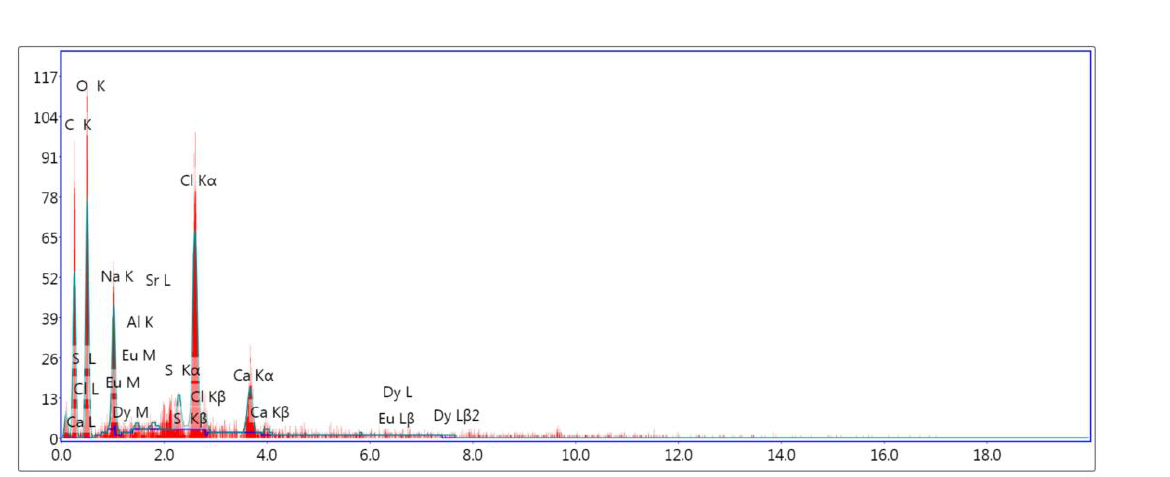
Figure 5. SEM images of PCP-16 at various enlargements.